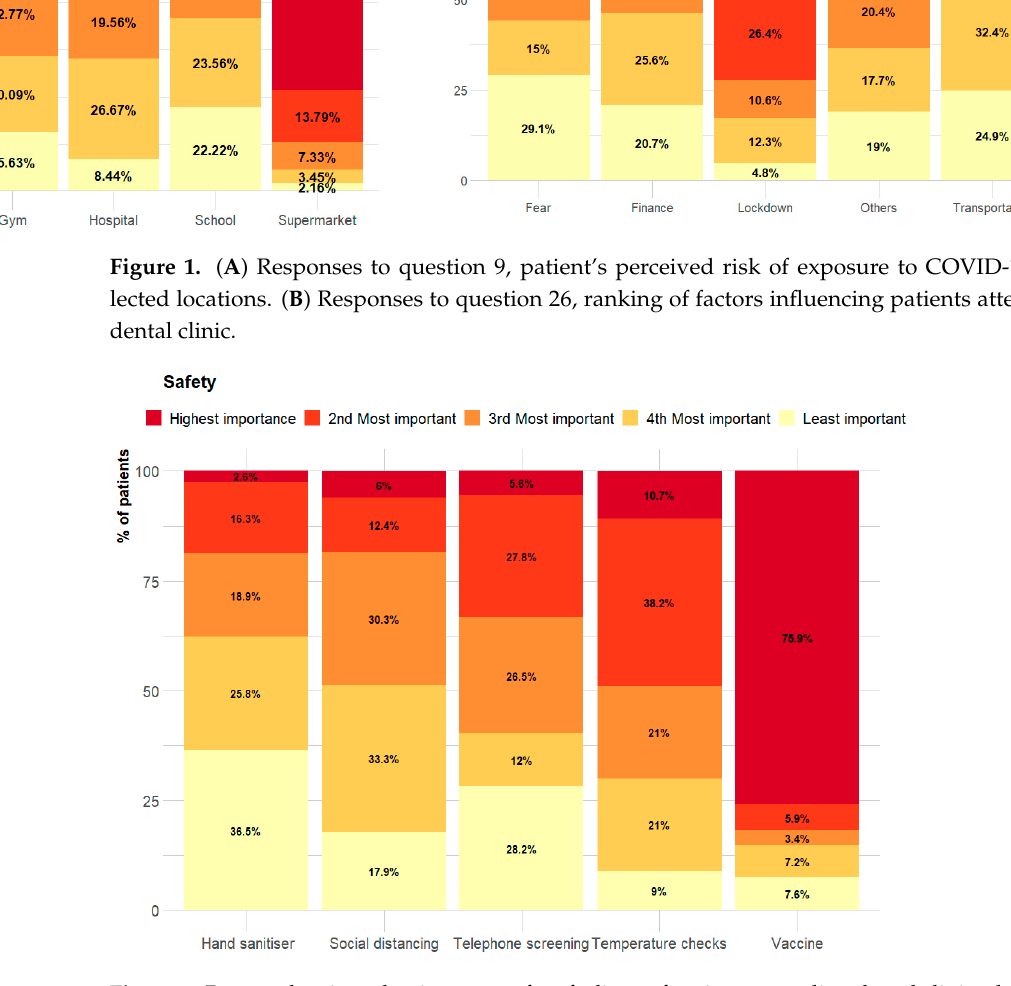
Figure 2. Reported actions that increase safety feelings of patients attending dental clinics during the COVID ‐ 19 pandemic.